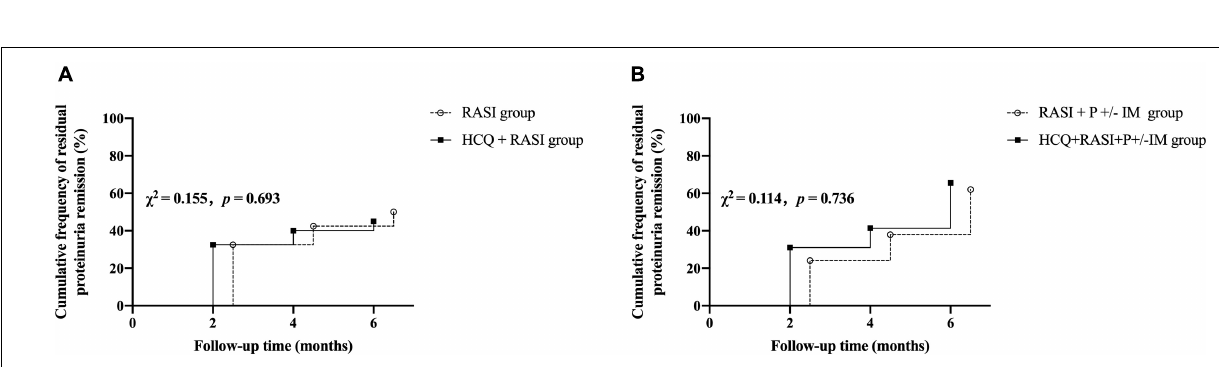
FIGURE 4 | The residual proteinuria and renal function during the follow-up period. 0, 2, 4, and 6 indicate the time of enrollment, the 2nd, 4th, and 6th month, respectively. (A) The residual proteinuria in the RASI group vs. the HCQ + RASI group. (B) The residual proteinuria in the RASI + P ± IM group vs. the HCQ + RASI + P ± IM group. (C) Scr in the RASI group vs. the HCQ + RASI group. (D) Scr in the RASI + P ± IM group vs. the HCQ + RASI + P ± IM group. *Represents statistical significance ( p < 0.05).